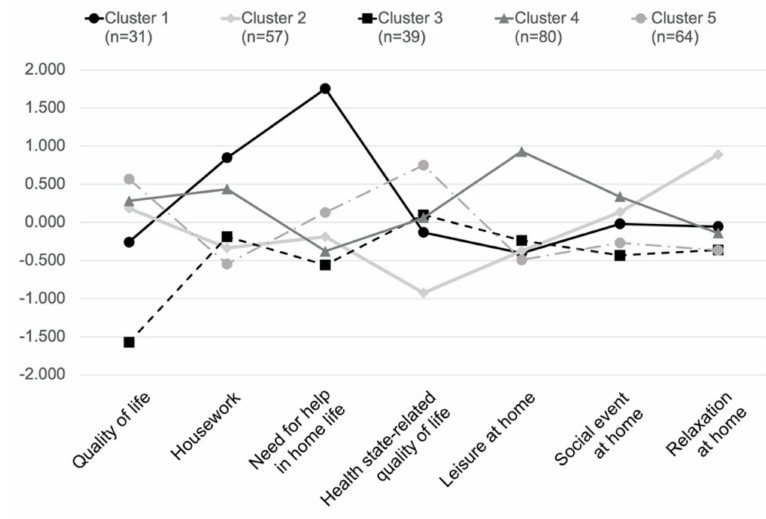
Figure 3. Clusters for residentially-based lifestyle of older people. Table 4. Cluster di ff erences by health